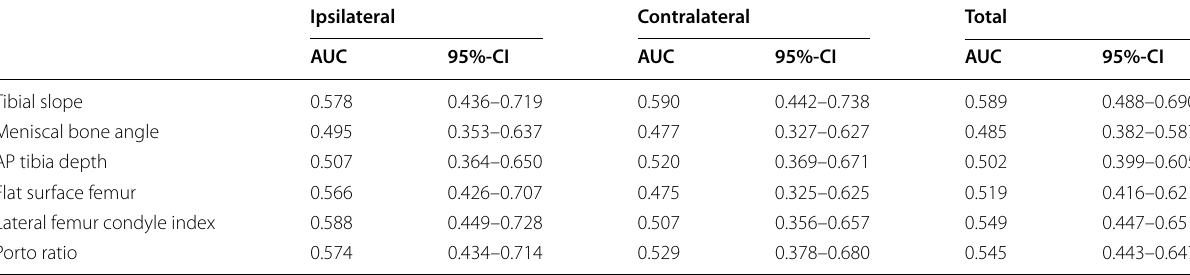
AP Anterior-posterior, AUC Area under the curve, CI Confidence interval